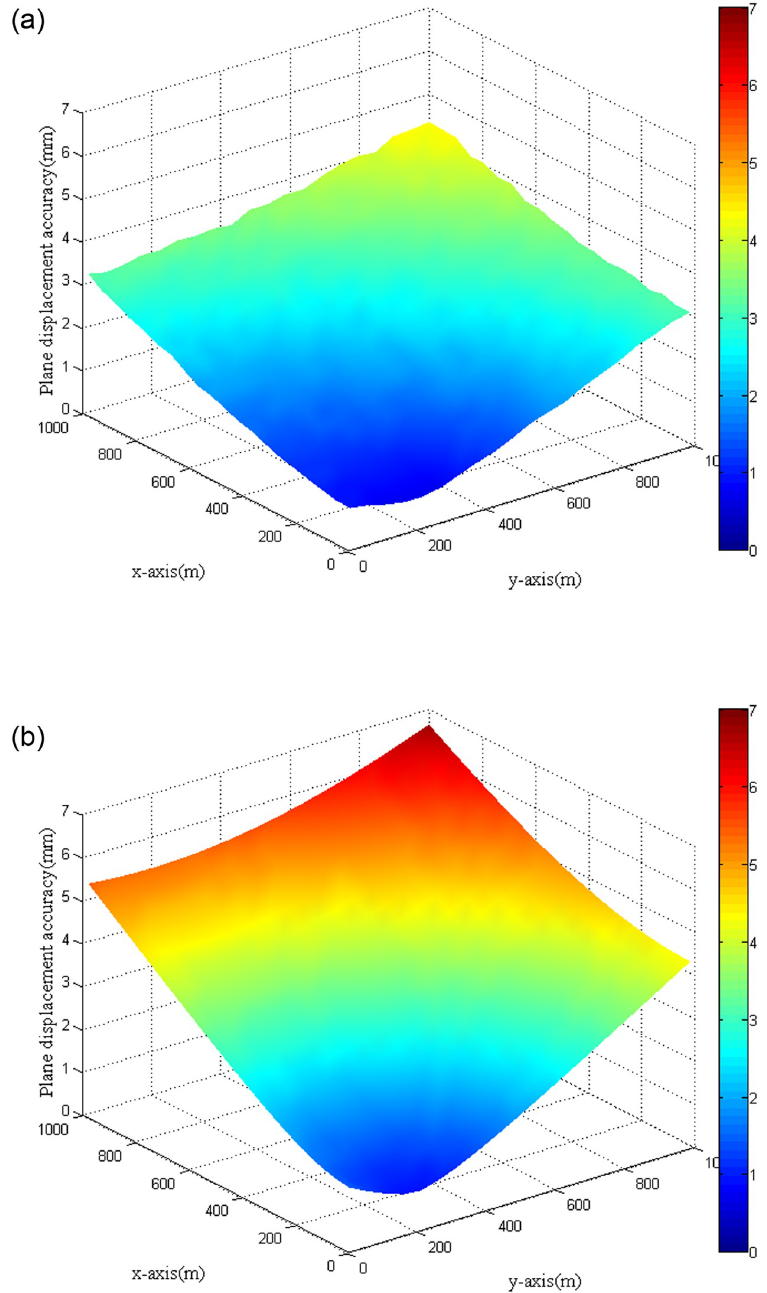
Fig 6. Plane displacement accuracy comparison. (a) Forward intersection method. (b) Polar coordinate method. When trigonometric leveling was applied to calculate the vertical displacement of the moni- toring point, the accuracy of vertical displacement was predominantly affected by vertical angle and slope distance observations when the effect of refraction was not taken into